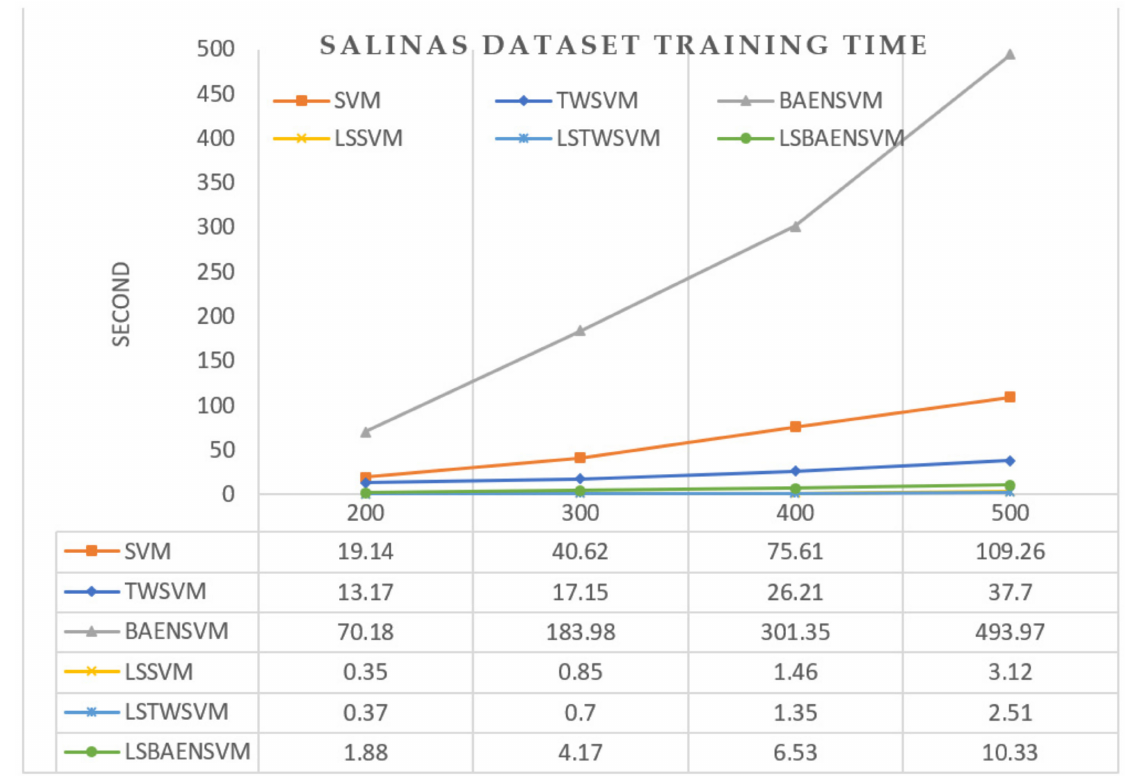
Figure 11. Time-consumption comparison of SVM, TWSVM, BAENSVM, LSSVM, LSTWSVM, and LSBAENSVM in different scales of the Salinas training